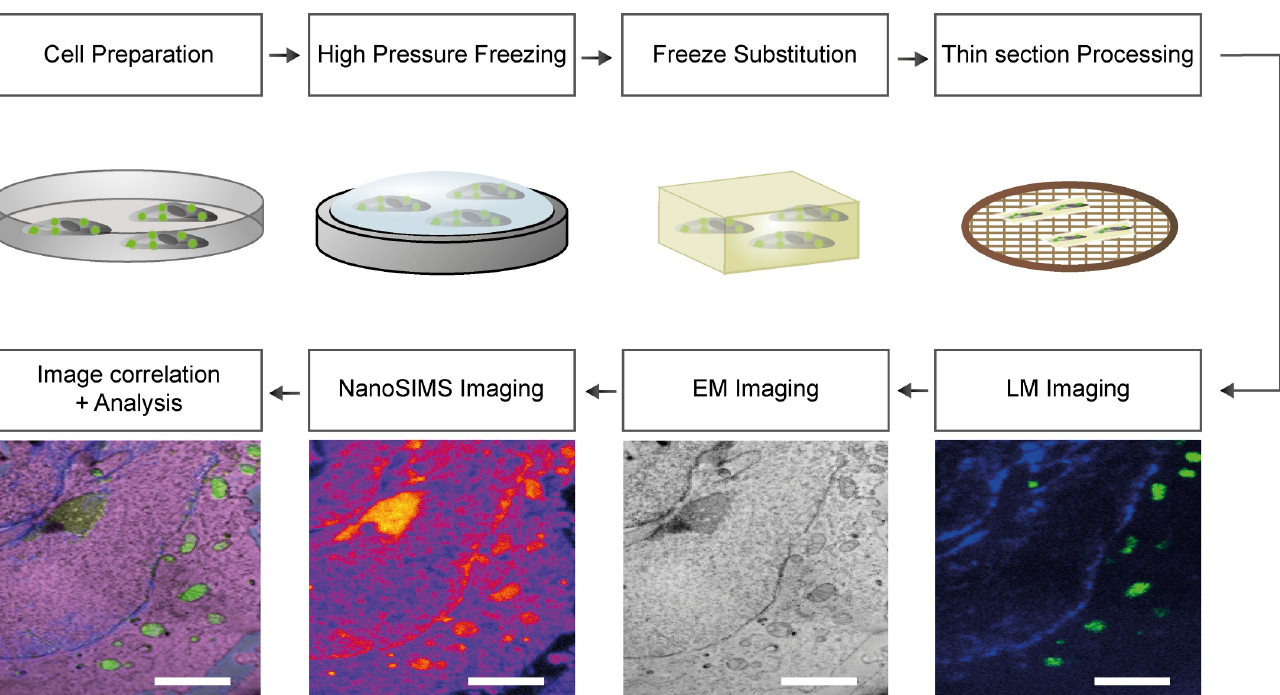
Fig 1. General overview of the workflow for CLEM-SIMS imaging. The cells are cultured following standard protocols, and fluorescence labelling can be applied to address specific questions. The cells are then immobilized by high pressure freezing, followed by freeze substitution. After the polymerization of the resin, the blocks are sectioned and the slides are placed on electrically conductive and referenced grids. Once the thin-sections are placed on grids, the first imaging step is fluorescent microscopy, followed by TEM, and finally by nanoSIMS. When the same areas have been scanned/imaged by the three techniques, the images are processed for registration and are analyzed. Scale bars: 3 μ